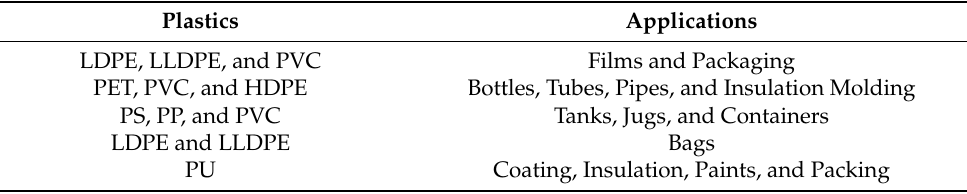
Table 1. Main plastics and their applications. Plastics Applications LDPE, LLDPE, and PVC Films and Packaging PET, PVC, and